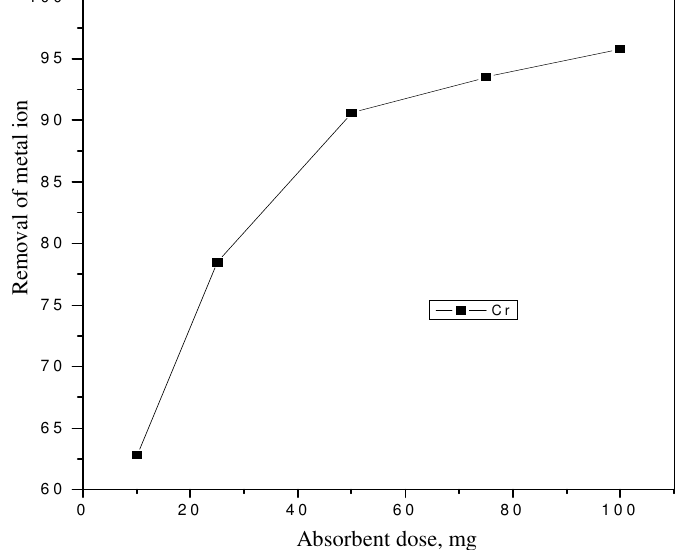
Figure 2. Effect of absorbent dose on the adsorption chromium ion.